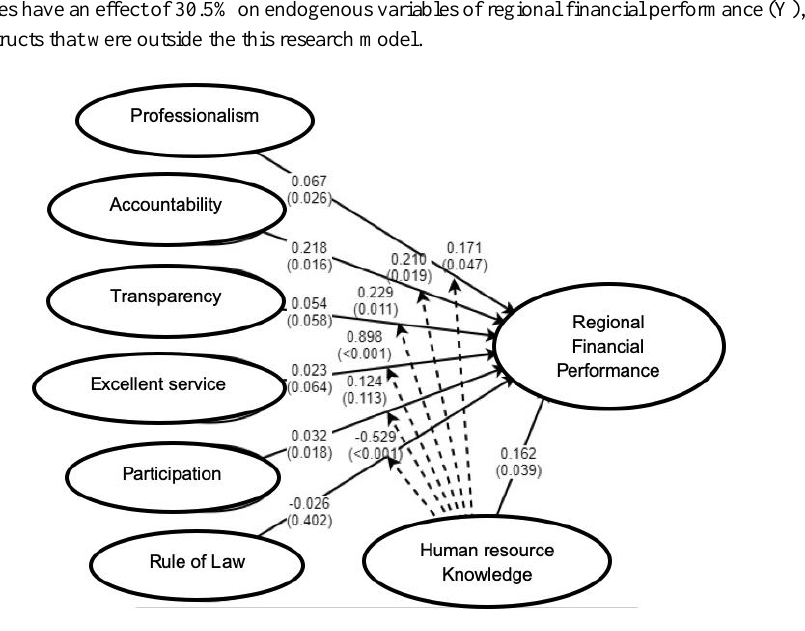
Figure 1: Research Model with Partial Least